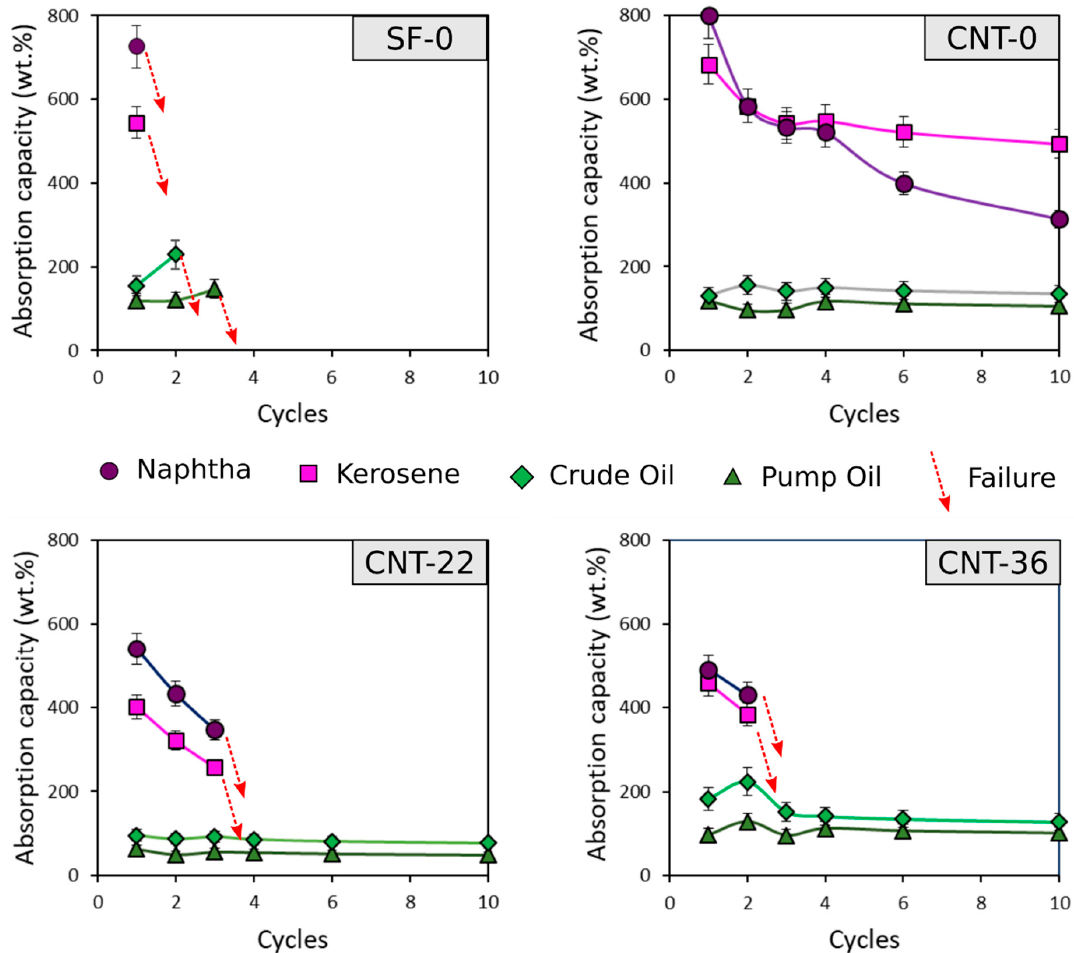
Figure 3. Absorption capacity up to 10 cycles for each investigated foam.